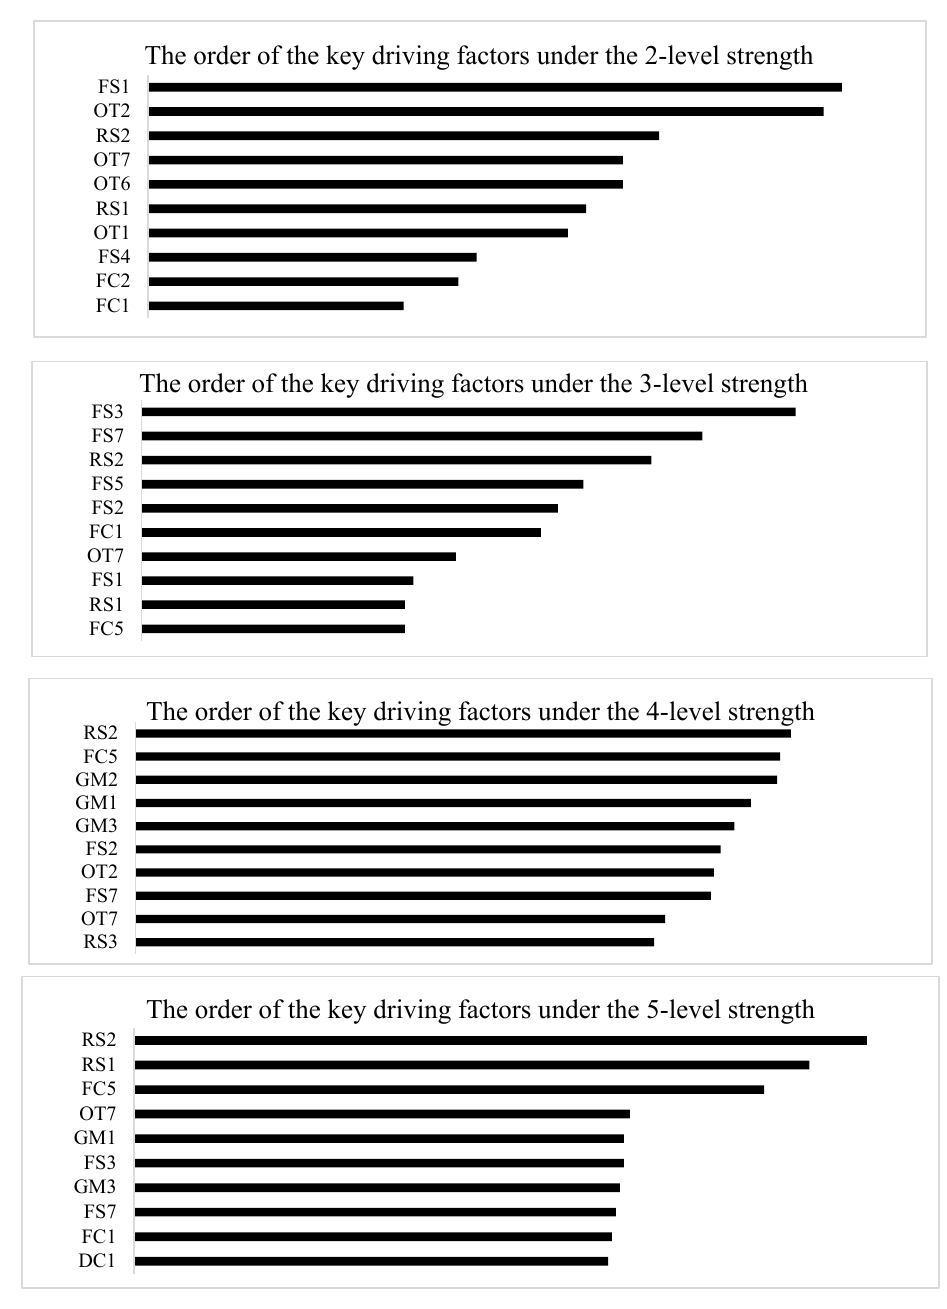
Figure 3. Ranking of critical driving factors under different drive strengths.